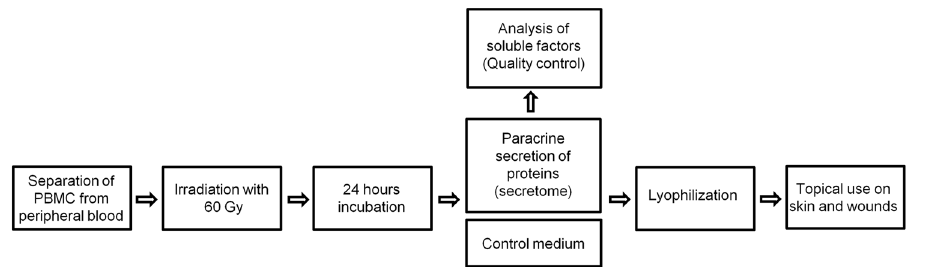
Figure 2. APOSEC production. Preparation process of APOSEC according to good manufacturing practice (GMP) in the facility of the Austrian Red Cross Blood Transfusion Service of Upper Austria (Linz, Austria), with the following steps. The first step was separating the PBMCs from the whole blood samples, inducing apoptosis via ionizing irradiation, and incubating for 24 h. During this 24 h, the PBMCs secrete a multitude of cytokines and chemokines. The quantity of cytokines is measured using ELISA and immunoassay (Luminex ® 100IS) for quality control. After the lyophilization, APOSEC is ready for topical use on skin and